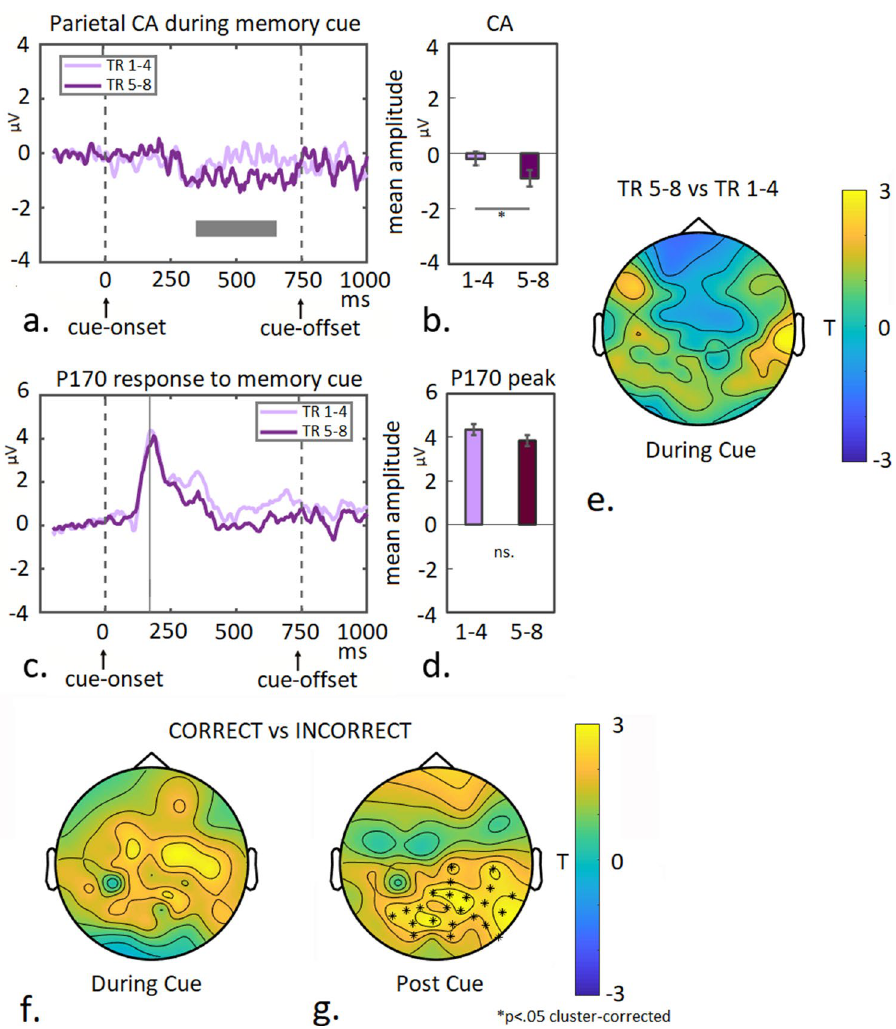
Figure 5. Parietal contralateral activity and midfrontal response during WM-cue-induced visualization. Plotted are the parietal CA difference waves ( a ) and midfrontal P170 responses ( c ) for both trial groups during recollection/visualization of the memorized colour-array, as probed by the memory-cue following the WM delay (t0 = memory-cue onset). Mean CA amplitudes are calculated and plotted for a 300 ms time-window while the memory-cue was on screen ( b ; indicated as gray box in a ) and for the midfrontal P170 peak ( d ; indicated as gray line at 170 ms in c ). Topographic T-map displaying the difference between trial-groups during memory-cue presentation ( e ; time-window indicated as gray box in a ). Topographic T-map displaying the difference between correct- and incorrect trials during memory-cue presentation ( f ) and immediately following cue presentation ( g ), asterisks indicate significant differences above electrodes ( p < .05